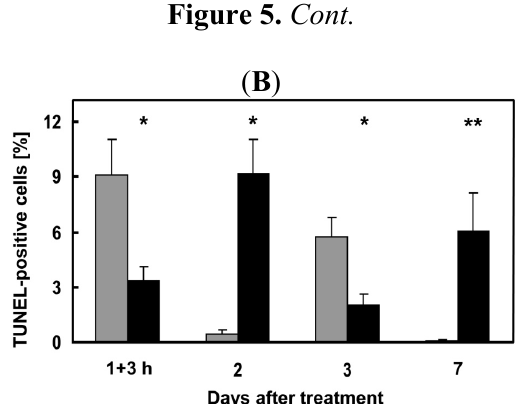
Figure 6. Time course of hepatocyte proliferation after treatment with APAP. Mice were treated as described in the legend to Figure 2. Cells were delivered via intrasplenic injection (+hMSC-HC), control mice received PBS ( − hBM-MSC). Three hours later (=1 day + 3 h after treatment), and 2, 3, and 7 days after treatment, livers were excised and tissue sections were processed to detect proliferating cells by immunohistochemical staining of PCNA. In ( A ) representative pictures of livers are shown at the relevant time points 2 and 3 days after treatment with APAP. Solid and open arrowheads indicate PCNA-positive nuclei in stained sections, from livers without and with treatment of hMSC-HC, respectively; The proliferation rate ( B ) was calculated as described in Materials and Methods. Values are means ± SEM from 2 to 3 livers ( n  2), from which at least five different sections were counted ( n  5). Values of controls without hMSC-HC (grey bars) are significantly different from values of livers with hMSC-HC (black bars) at the * p  0.01 or ** p  0.025